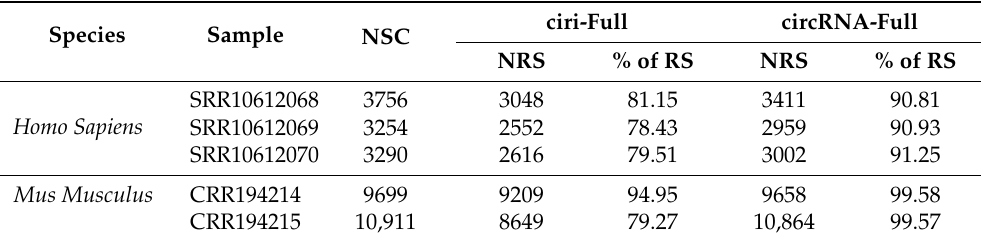
Table 1. Number of reconstructed sequences produced by ciri-full and circRNA-full for different